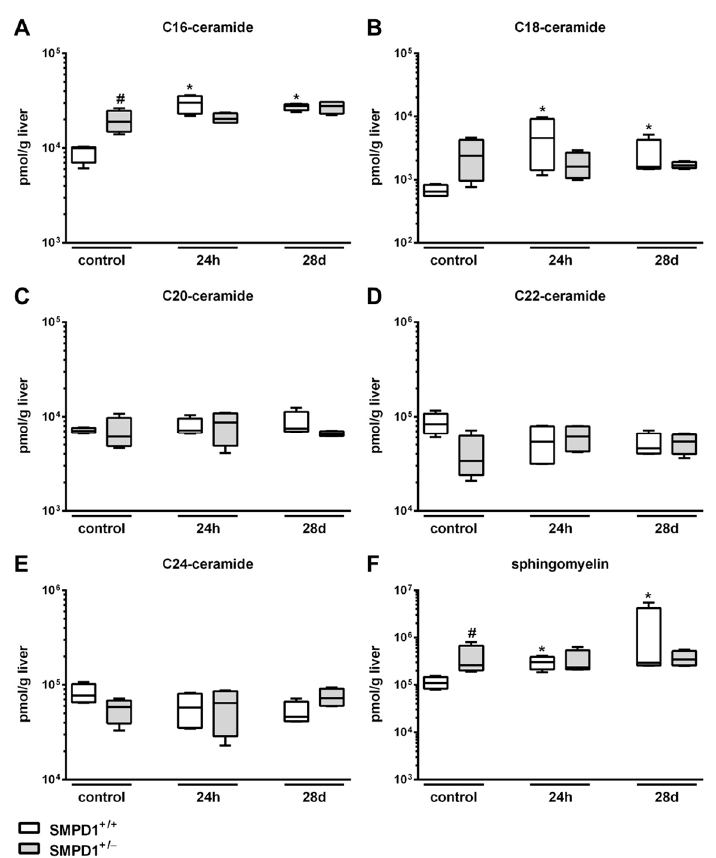
Figure 2. Increased hepatic ceramide levels in SMPD1 +/+ mice following polymicrobial sepsis induction .